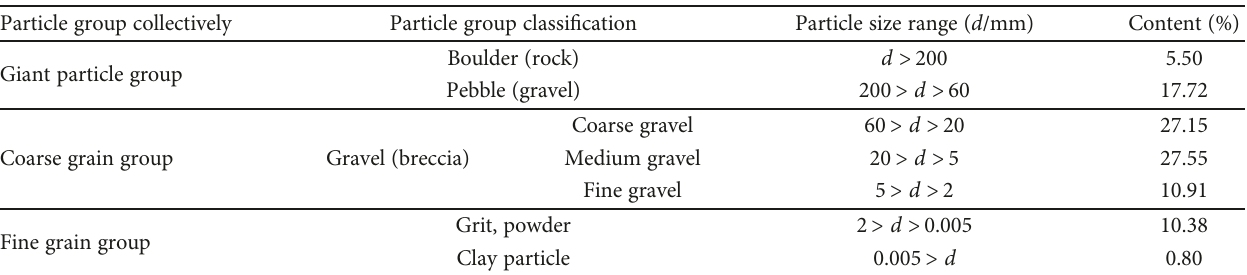
Table 4: Content of each grade of dispersion in the dump